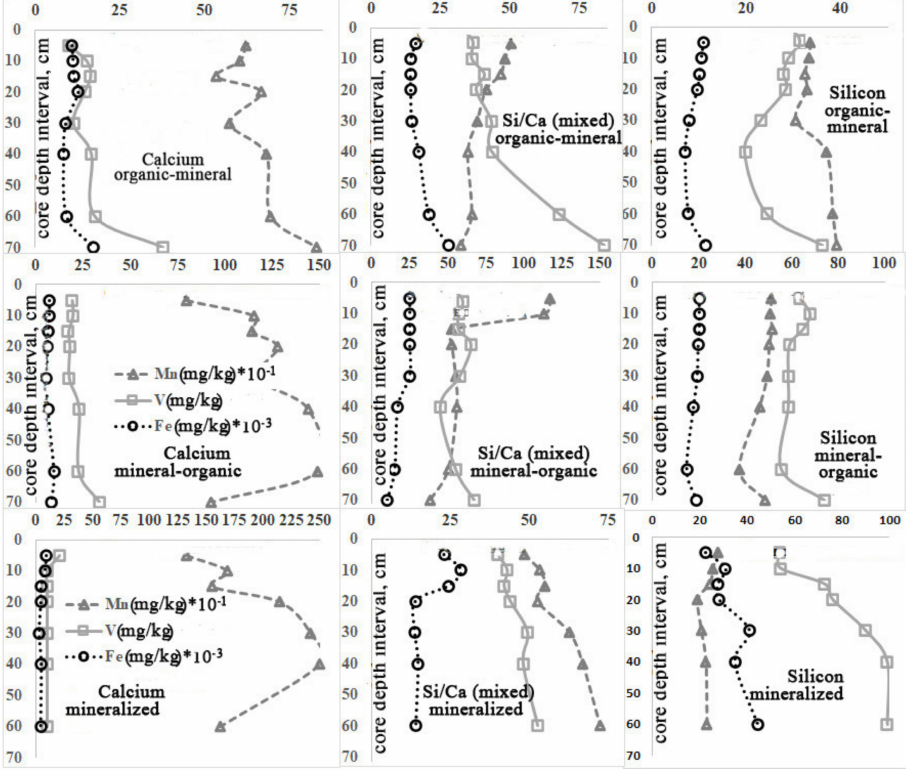
Figure 7. Vertical distribution of the averaged contents of Mn (mg/kg)*10 − 1 ; V (mg/kg) and Fe (mg/kg)*10 − 3 in sapropel sediments of various types (organic–mineral; mineral–organic; mineral- ized) and class (Silicon; Calcium, Si/Ca (mixed)) along cores (according to our